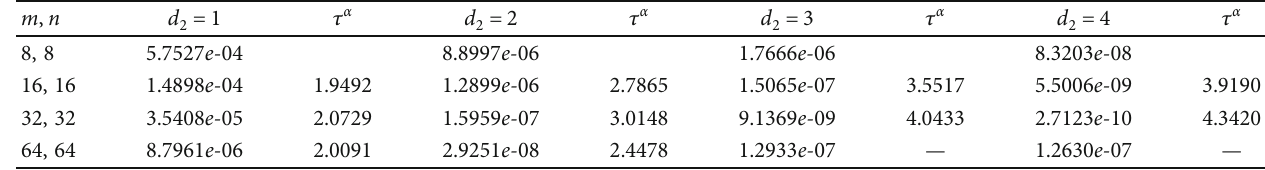
= 7 at t = 1 for Chebyshev nodes. 1